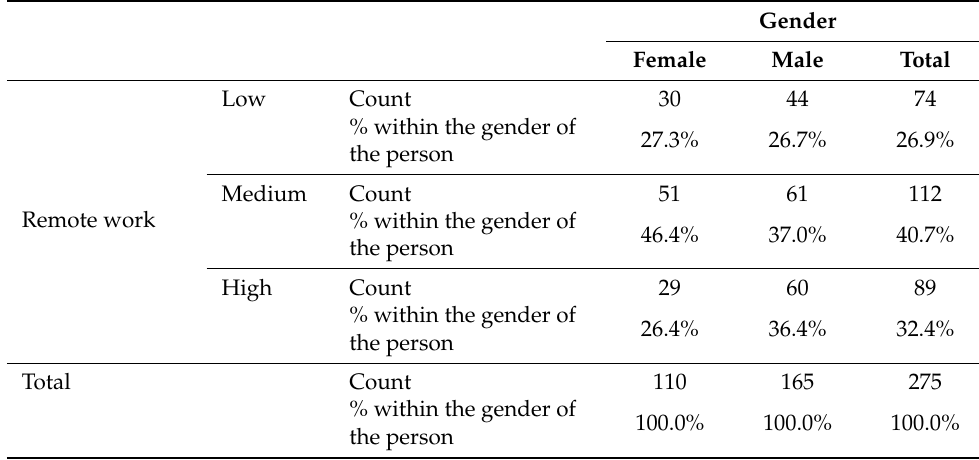
Table 9. Cross table of remote work level and gender.